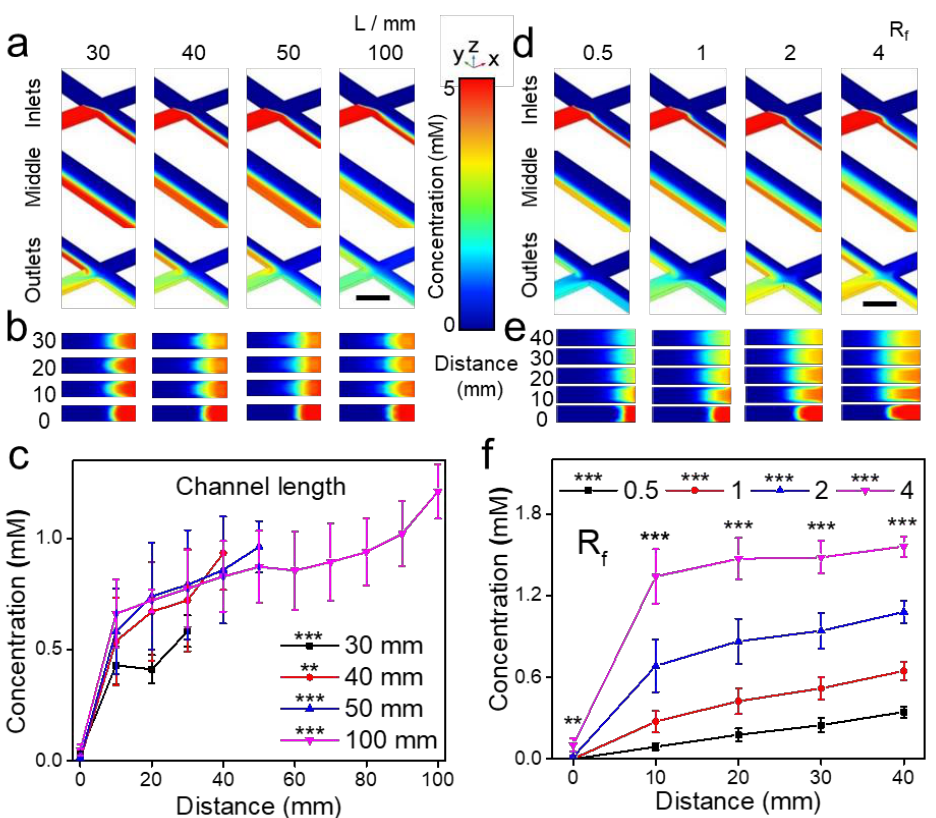
Figure 2. COMSOL simulation to show the impact of channel length and flow rate ratio ( R f ) on the concentration-controlled process. To explore the impact of channel length: ( a ) Concentration distribution of inlets, middle site and outlets of microfluidic chips with lengths of 30, 40, 50, 100 mm. ( b ) Concentration distribution of cross sections at the distances of 0, 10, 20, 30 mm away from inlets. ( c ) Calculate the concentration distribution of cross sections at the distances of 0, 10, 20, 30 mm away from inlets in microfluidic chips of 30, 40, 50, 100 mm. To explore the impact of R f : ( d ) Concentration distribution of channel inlets, middle site and outlets under the flow rate ratio of 0.5, 1, 2, 4. ( e ) Concentration distribution of the cross section at the distances of 0, 10, 20, 30 mm away from inlets. ( f ) Calculate the concentration distribution of cross section at the distances of 0, 10, 20, 30 mm away from inlets under flow rate ratio of 0.5, 1, 2, 4. Data are shown as mean ± SEM, n > 50, * p < 0.05, ** p < 0.01, *** p < 0.001.